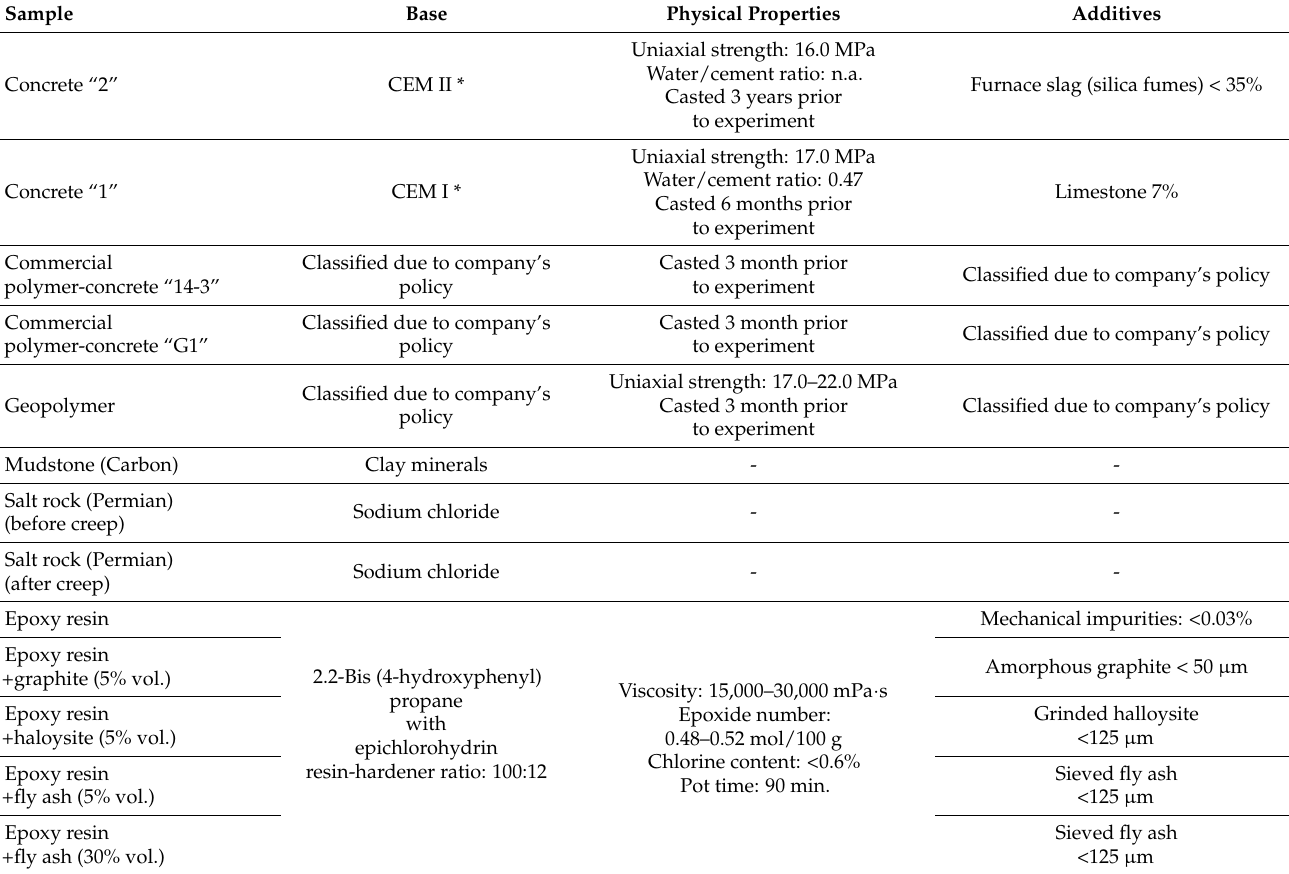
Table 1. Details of investigated